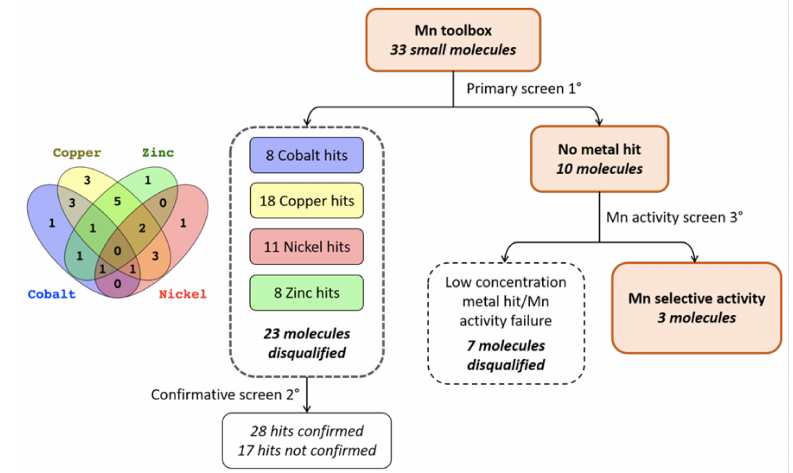
Figure 2. Screening paradigm for small molecule activity against other divalent metals. A primary screen of 33 small molecules was completed, assaying each molecule for fluctuations in Fura-2 fluorescence after Co, Cu, Zn, and Ni exposure (see Supplementary Table S1). Significant deviations (by one-way ANOVA, Sidak’s multiple comparisons) were detected in 23 of the small molecules, leaving 10 that were not significantly different (and within two standard deviations from the vehicle mean; see Supplementary Table S2). These 10 were tested in the presence of lower concentrations of each metal, and it was confirmed that they could indeed influence intracellular Mn levels. Three molecules remained.